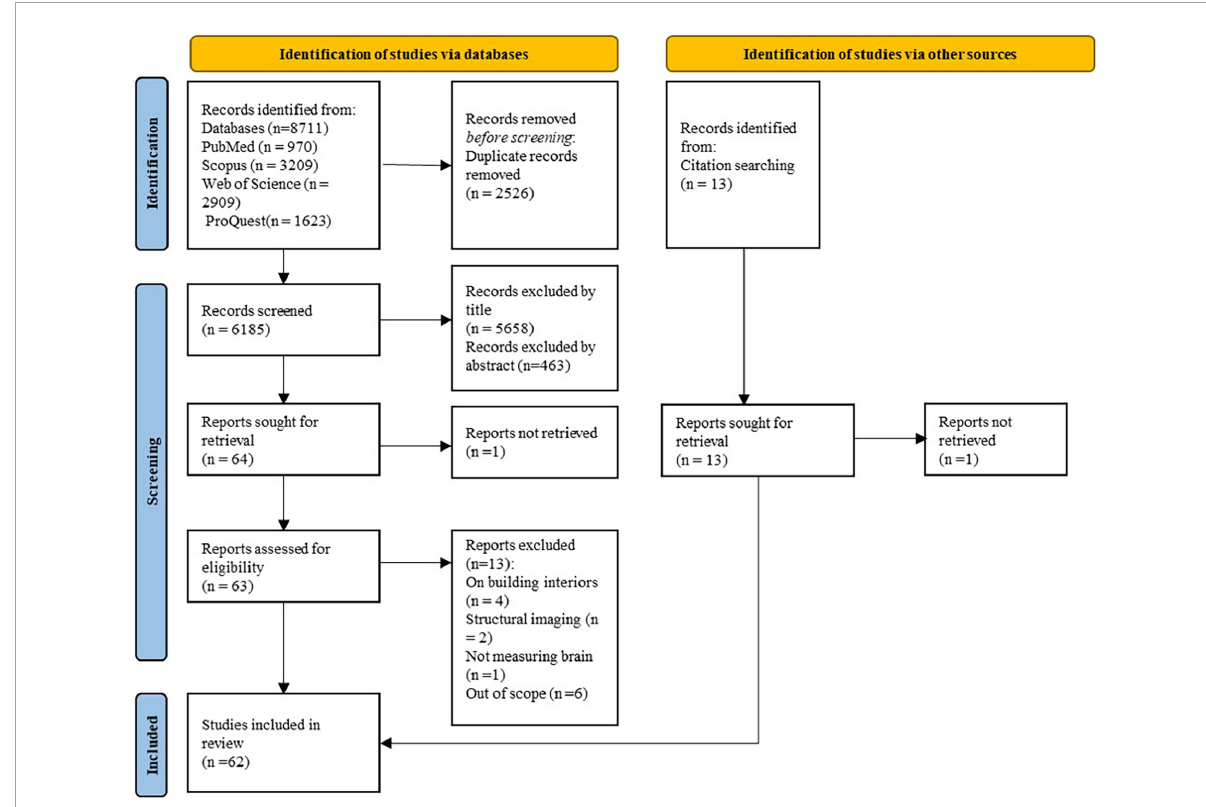
FIGURE2 Preferred reporting items for systematic reviews and meta analyses (PRISMA) flow diagram of the selection